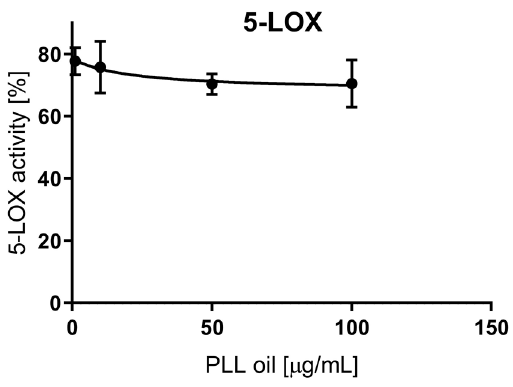
Figure 2. The anti-inflammatory e ff ect of PLL-EO toward soybean lipoxygenase (LOX) activity.